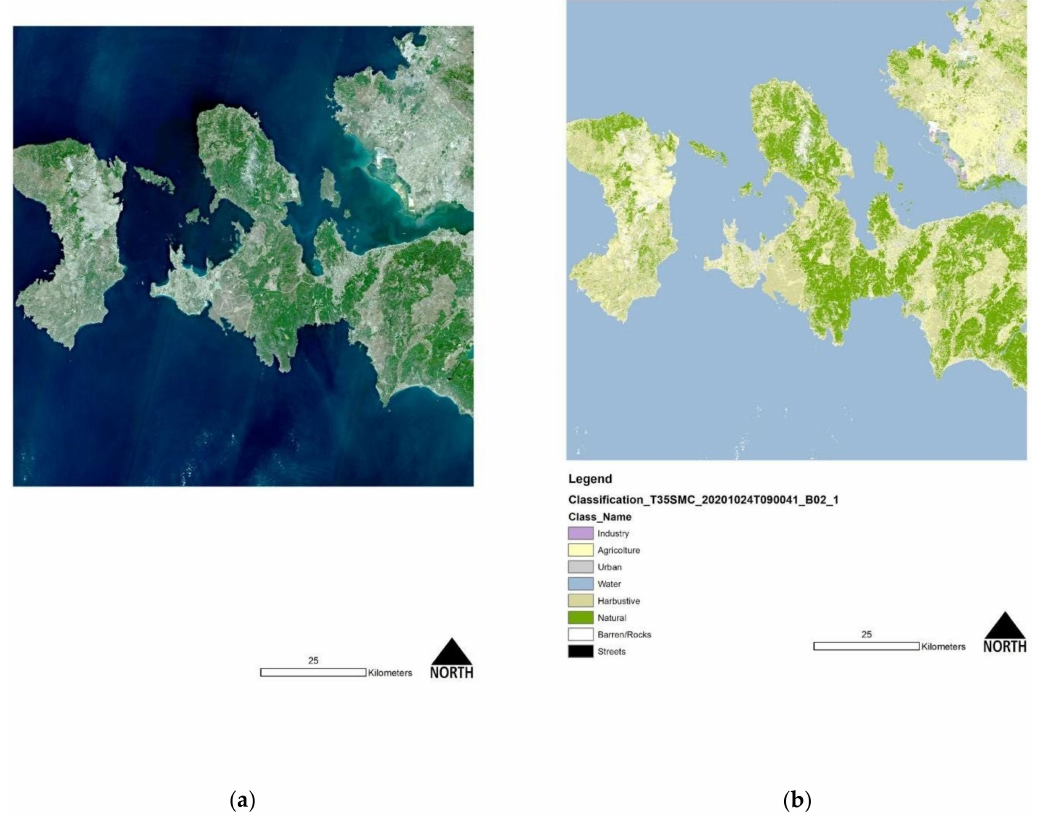
Figure 5. ( a ) original RGB composite bands, ( b ) post-processed land-use Land Cover by supervised